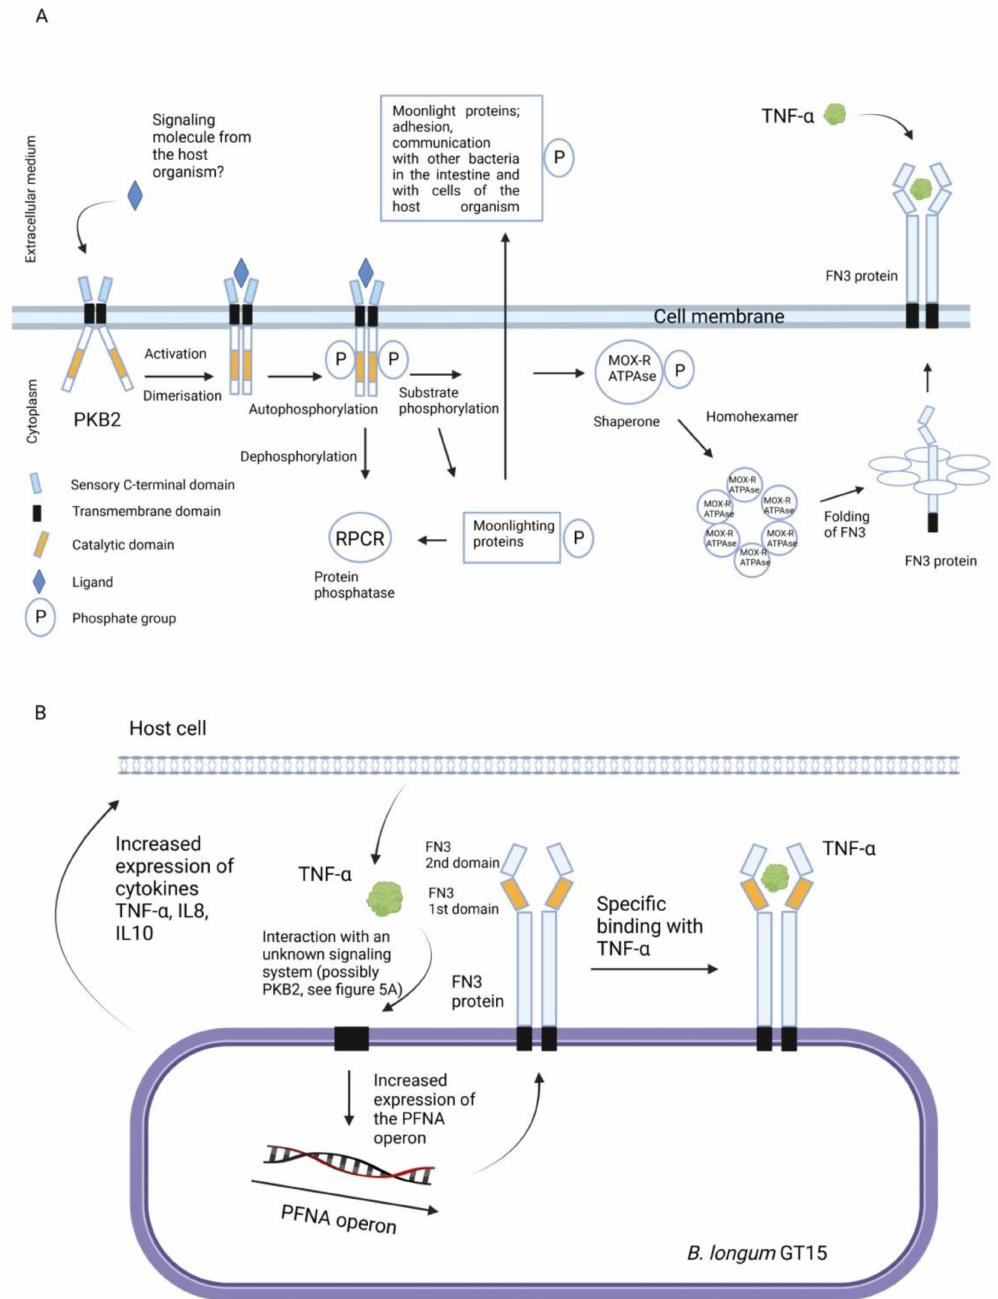
Figure 5. Hypothetical schematic representation of the role of the PFNA operon in the interaction of bifidobacteria with the host immune system. ( A ) Activation of the PKB2 signaling system. The serine-threonine protein kinase (PKB2), following its activation by an unknown ligand, autophosphorylates, [57] and phosphorylates other substrates. The phosphorylated substrates are moonlighting proteins [54], which participate in the adhesion and interaction of bifidobacteria with cells of the host organism. PKB2 also phosphorylates a protein of the PFNA operon, the MoxR-ATPase protein encoded by the aaa-atp gene [54]. MoxR-ATPase is a chaperone and thus is possibly involved in folding of proteins, including, FN3. The FN3 protein is capable of specifically binding to TNF- α [22]. ( B ) The strain B.longum GT15 increases the expression of cytokines TNF- α , IL8 and IL10 in human cells [89]. Apparently, TNF- α interacts with an unknown signaling system of B. longum GT15 (possibly PKB2), triggering an increase in the expression of genes of the PFNA operon, including the fn3 gene [89]. Adapted from